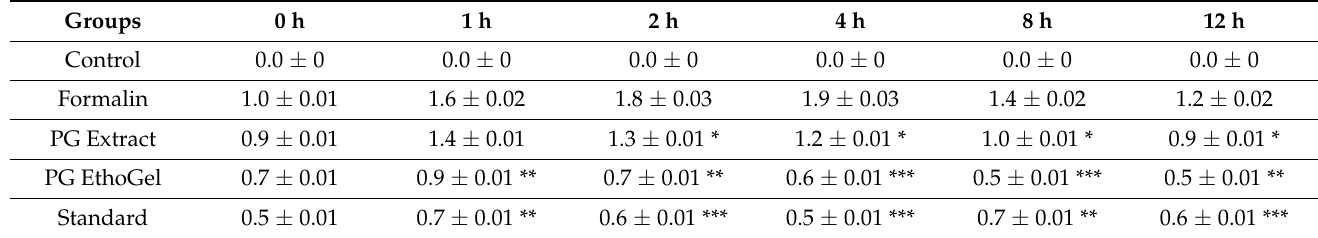
Figure 10. Inflammation volume observation in rats of ethosome suspension and gel. Table 5. Paw volume of different samples at different time intervals.